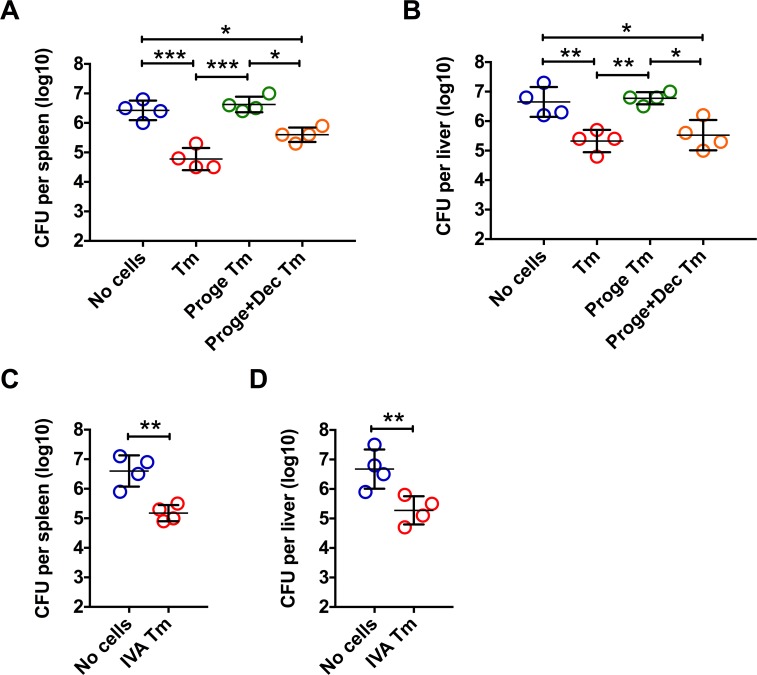
Impact of progesterone on immune protection of antigen-non-specific CD8 Tm cells in pregnant mice.As shown in (A) and (B), CD8 Tm cells were generated by immunization with rAdHuOVA. At 40 days post immunization, some mice were injected with progesterone(Proge) for 2 weeks, with or without decitabine(Dec) treatment. OVA antigen-specific CD8 Tm cells purified from the spleen and MLN were adoptive transferred into antigen-inexperienced pregnant mice followed by LM infection. Bacterial CFU numbers in the spleen (A) and the liver (B) at 72 hours post infection are shown. In (C) and (D), influenza A virus NP366-374 antigen-specific CD8 Tm cells (IVA Tm) were generated by immunization with the A/PR8/34 influenza virus. At 40 days post immunization, NP366-374 antigen-specific CD8 Tm cells purified from the spleen and MLN were pooled and adoptively transferred into antigen-inexperienced pregnant mice followed by LM infection. Bacterial CFU numbers in the spleen (C) and the liver (D) at 72 hours post infection are shown. Error bars represent mean±SD. One-way ANOVA and Tukey’s multiple comparisons test was used to compare between multiple groups. * P<0.05; ** P<0.01; *** P<0.001. Data in (A) and (B) are representatives of 2 independent experiments with n = 4 per group. Data in (C) and (D) are representatives of 2 independent experiments with n = 4 per group.